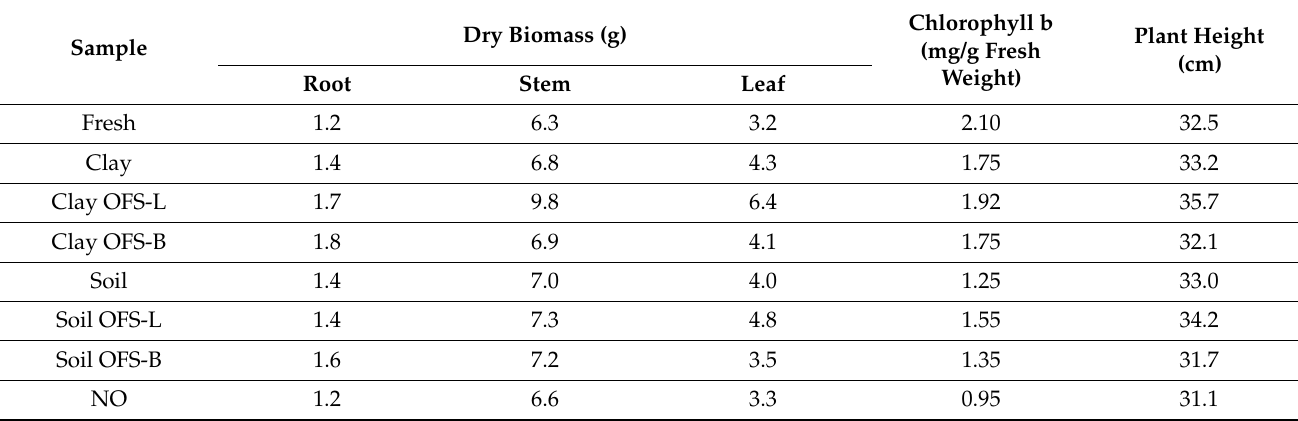
Table 3. Cd (II) adsorption effect on the biomass, chlorophyll content, and plant height of Cyperus alternifolius plants during bioretention